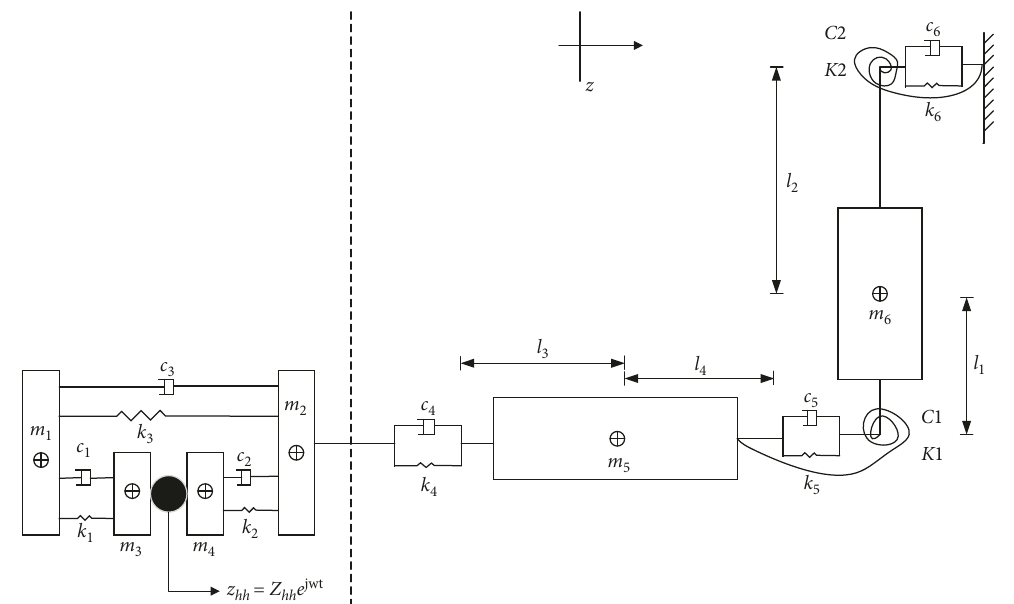
Figure 1: The hand-arm system biomechanical model with elbow